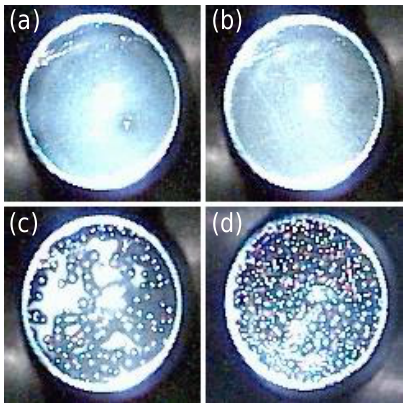
Figure 9. Images of the condensate layer at different conditions. The diameter of the mirror is 7mm. Top left: supercooled liq- uid water at T = − 28 . 0 ◦ C. Top right: fine frost condensate at T = − 87 . 9 ◦ C. Bottom left: coarse frost layer with patches of small liquid drops at T = − 26 . 8 ◦ C. Bottom right: coarse frost layer at T = − 88 . 9 ◦